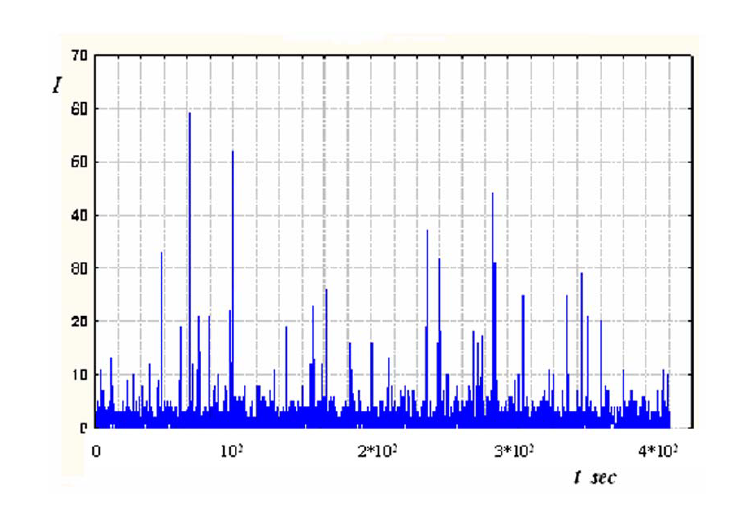
Figure 1. Example of photocurrent I time distribution for fish eggs at development stage 16, full time scale 4 · 10 2